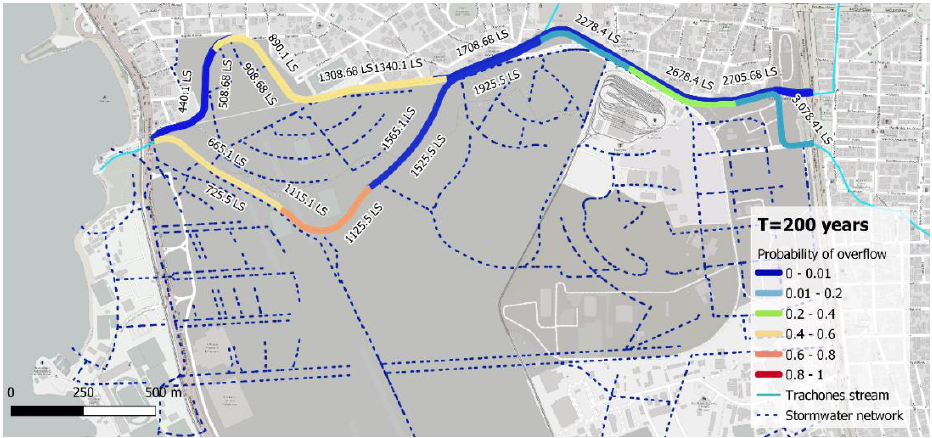
Figure 11. Mapping of probability of overflow classes across the 24 lateral structures of lower Trachones drainage network, for 𝑇 = 200 years.